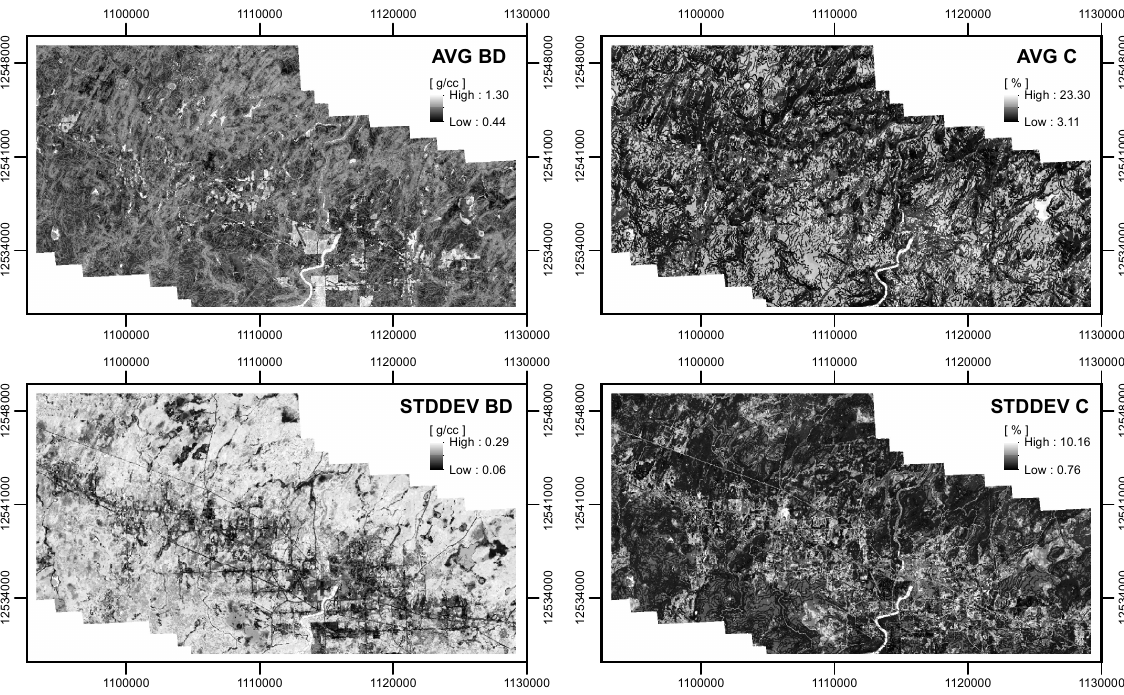
Figure 5. Prediction maps for AVG BD, AVG C , STDDEV BD and STDDEV C for the 0-15 cm depth layer for the respective RF models corresponding to 12